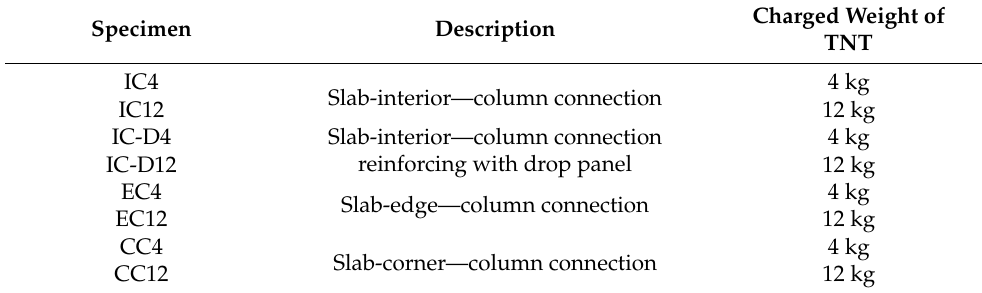
Table 3. Specimen descriptions.